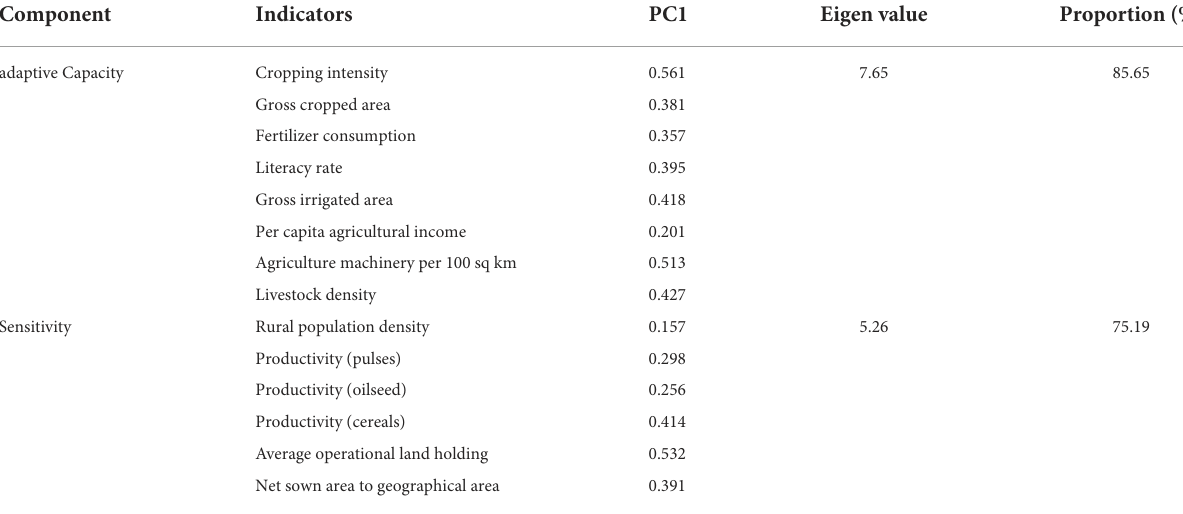
TABLE 3 None rotated factor loadings from first principal component (PC1) of adaptive capacity and sensitivity.